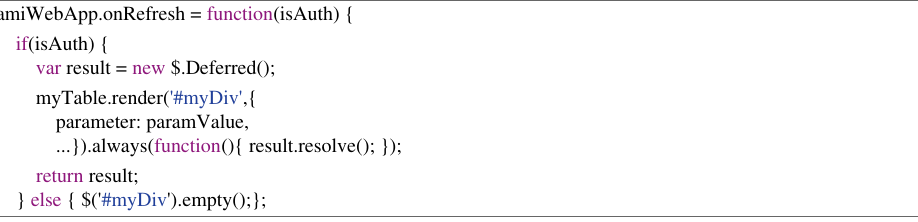
Fig. 3. AWF environment setup.